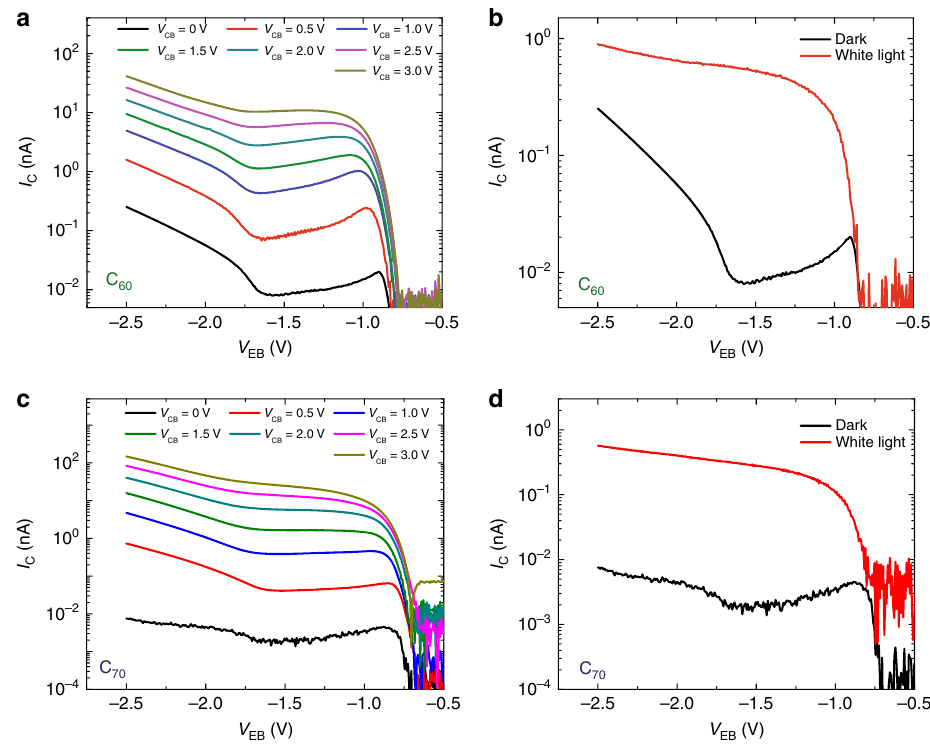
Fig. 4 Manipulation of the negative differential resistance. a Dependence of the direct hot-electron current, I C , of a C 60 hot-electron transistor on V EB for different collector-base bias, V CB , at 180 K. b Hot-electron current I C of C 60 based device for V CB = 0 V at 180 K in dark (solid black line) and under white- light irradiation (7.5 mW cm − 2 illuminating an area of 1 cm 2 ) (red solid line). c I C of a C 70 based hot-electron transistor on V EB for different collector-base bias, V CB , at 180 K. d Hot-electron current I C of a C 70 based device for V CB = 0 V at 180 K in dark (solid black line) and under white-light irradiation (7.5 mWcm − 2 illuminating an area of 1 cm 2 ) (red solid line) NATURE COMMUNICATIONS| (2019) 10:2089